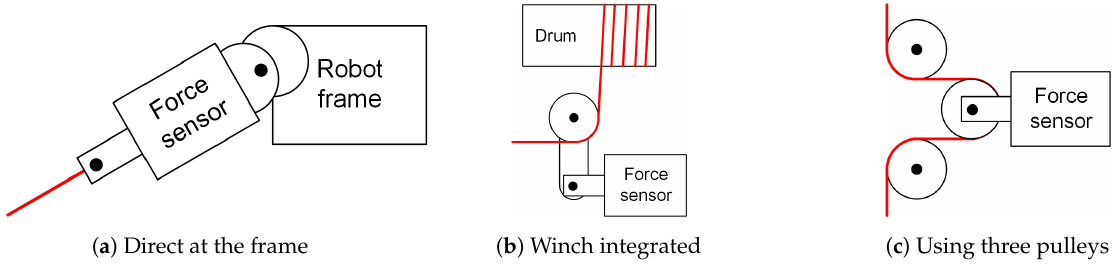
Figure 2. Examples of commercial off-the-shelf devices for measuring cable tension.